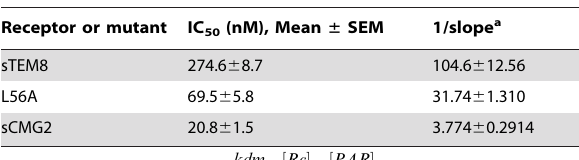
Table 1. Data results of the cell protection assay.